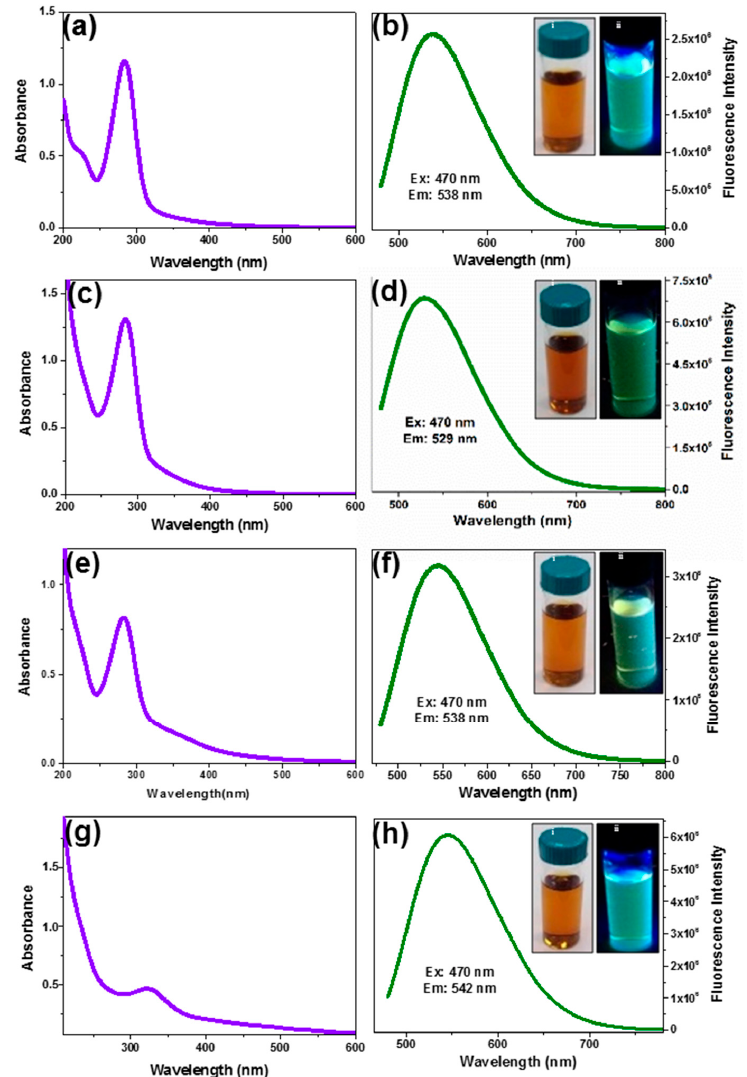
Figure 1. UV-vis and emission spectra of ( a , b ) Pear CD, ( c , d ) Avocado CD, ( e , f ) Kiwi CD and ( g , h ) Citrate CD. Inset: Photographs of the corresponding CD under (i) daylight and (ii) UV light.